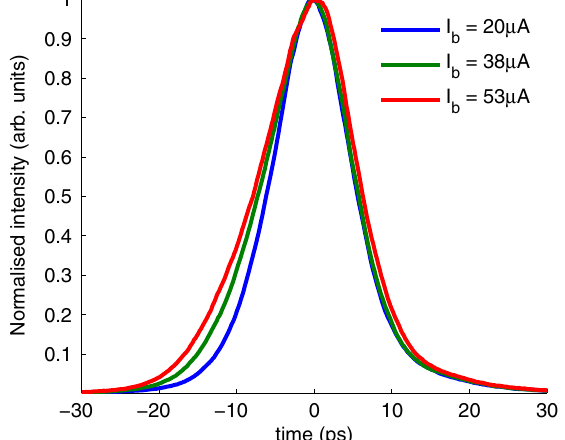
FIG. 10. Power emitted in the 60–90 GHz bandwidth as a function of current for two values of (cid:3) 1 . Data was measured at 1.5 and 2.2 MV.